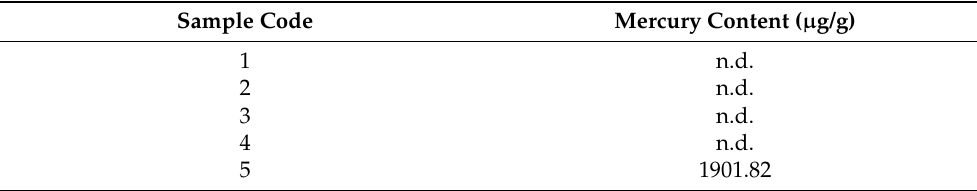
Figure 5. Calibration curve of mercury on low concentration. Table 3. Mercury concentration in the sample